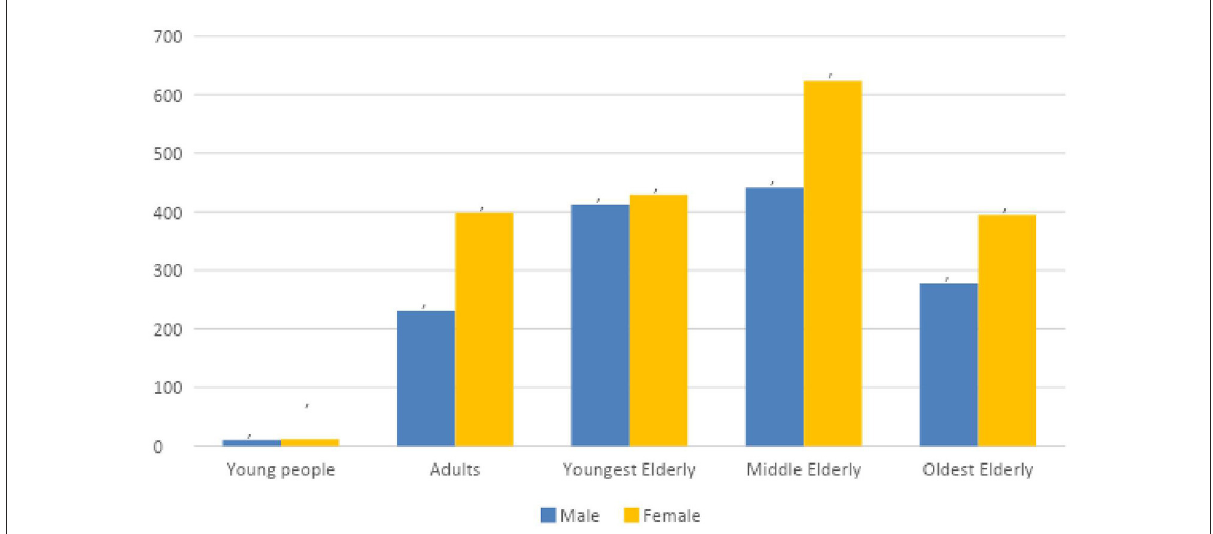
FIGURE1 Distribution of age and sex of reported falls (campus Kortenberg). Representation of the distribution of gender and age. Incidents where age and/or gender were unknown were excluded.